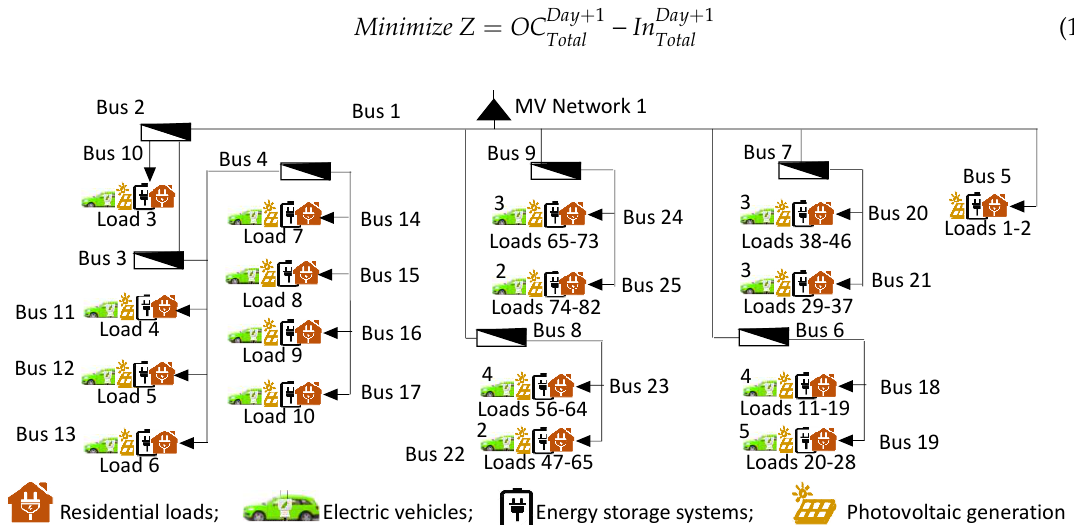
Figure 3. Residential 25-bus SMG in a 400 V system [35] .